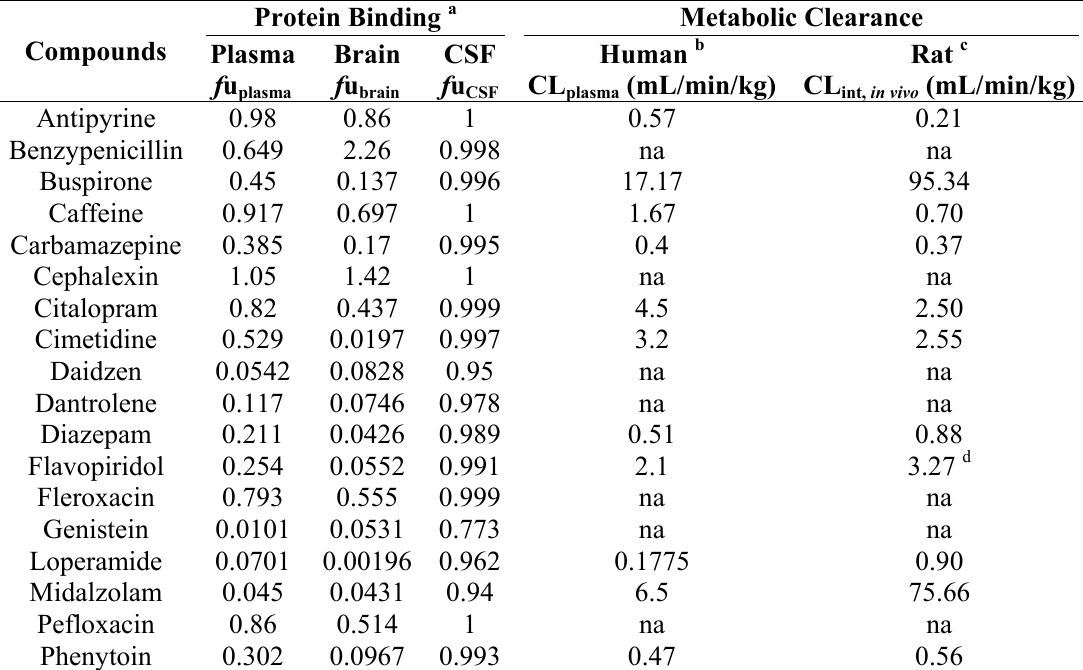
Table S8. Protein binding and metabolic